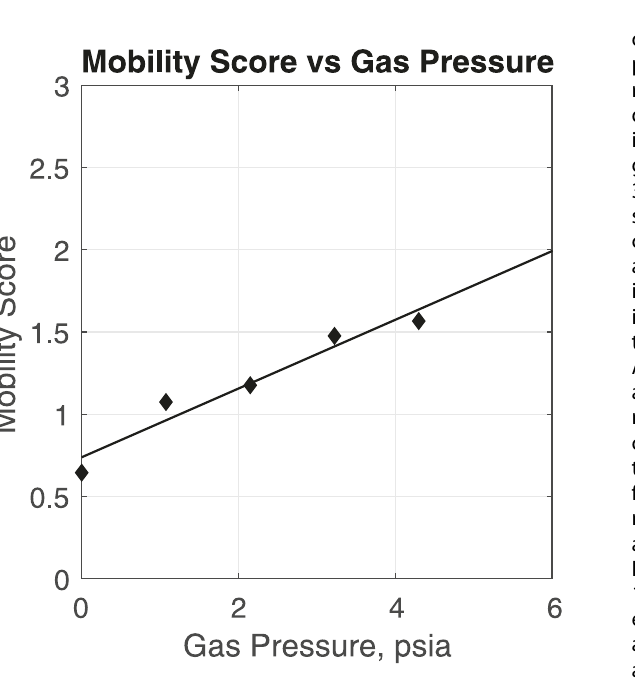
Fig. 1 Mobility score as a function of gas pressure in the spacesuit. The mobility score is derived from the energy expendi- ture simulations with assistive robotic actuators shown in Table 1. These scores are then normalized by the metabolic cost of unsuited walking without actuators (510 kcal/h). As a result, a mobility score of 2 represents a spacesuit environment that requires twice the amount of energy expenditure as that of unsuited